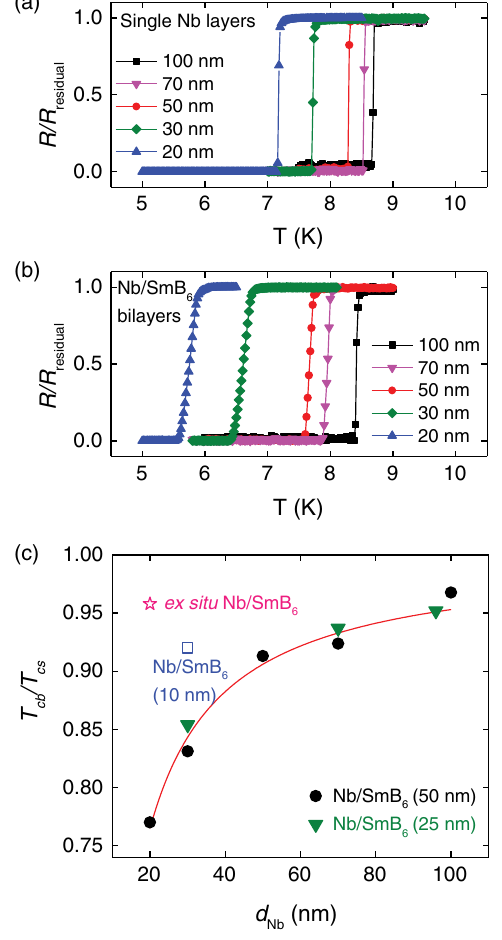
FIG. 4. Proximity effect in Nb = SmB 6 bilayer. Resistance versus temperature curves of (a) single Nb layers and (b) Nb = SmB 6 bilayers for different Nb layer thicknesses ( d ) where the SmB 6 Nb layer thickness is fixed to be 50 nm. Each Nb layer is deposited on SmB 6 in situ . The resistance values are normalized by values obtained at temperatures slightly above each transition temper- =T ature ( R ). (c) T (i.e., ratio of T of Nb = SmB 6 bilayer cb cs c residual to T of single Nb layer) as a function of d . The data points from c Nb bilayers with different SmB 6 layer thicknesses (10 and 25 nm) are also included. The solid line is a fit using the Usadel equation. The =T star indicates T of the Nb = SmB 6 bilayer where 20-nm Nb is cb cs deposited on SmB 6 (50 nm) after its surface is first exposed to air, forming an ex situ interface.